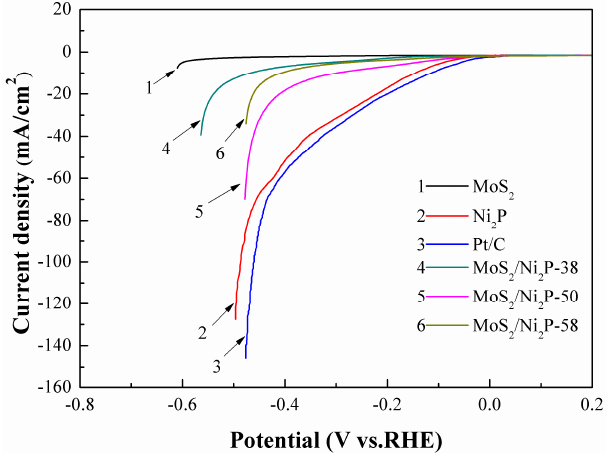
Figure 5. LSV curves of the pure MoS 2 , Ni 2 P, three MoS 2 /Ni 2 P hybrids, and commercial 20 wt % Pt/C. Scan rate: 2 mV/s, potential window: − 0.8~0.2 V (vs. RHE).